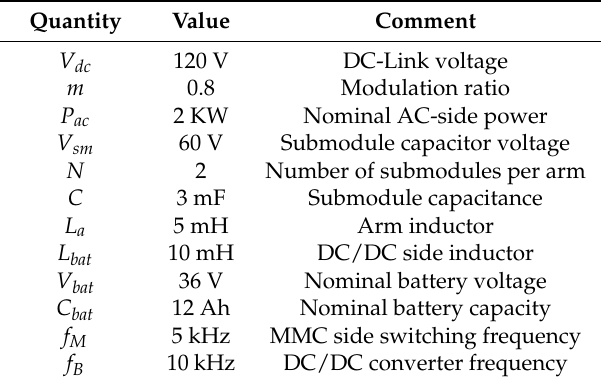
Figure 10. Prototype of three phase MMC-BESS. Table 2. Parameters of experiment prototype